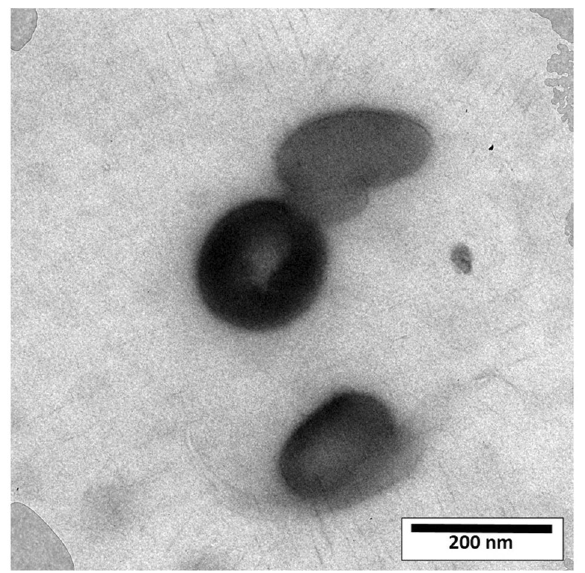
Fig. 2 TEM image of pH responsive PTX/niosome (pH = 7.4), ori- ginal magni fi cation: